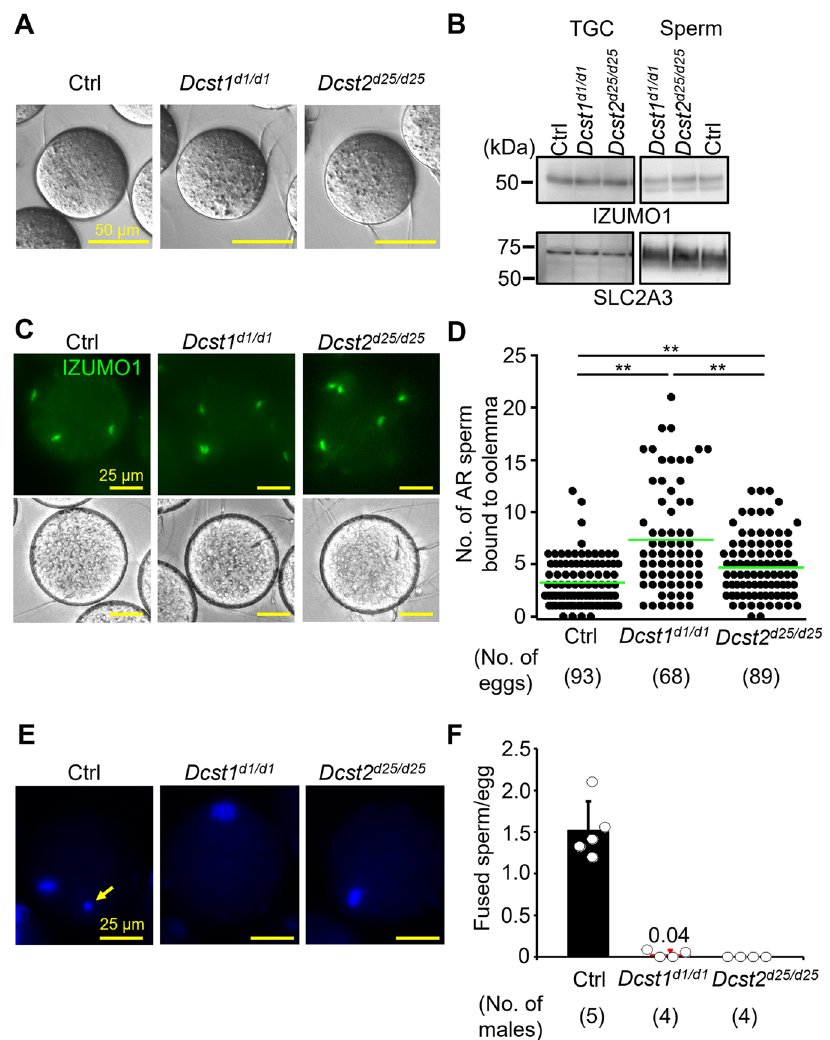
Fig. 2 Adhesion and fusion ability of Dcst1 and Dcst2 mutant sperm to oocyte plasma membrane. A Binding ability. Dcst1 KO and Dcst2 KO sperm could bind to the oolemma after 30 min of incubation. The scale bars are 50 μ m. B Detection of IZUMO1. The band signals of IZUMO1 in TGC and sperm of Dcst1 d1/d1 and Dcst2 d25/d25 male mice were comparable to the control wild-type sperm. SLC2A3, one of proteins in sperm tail, was used as the loading control. C , D Acrosome status of binding sperm. Live sperm bound to the oolemma were stained with the IZUMO1 antibody, and IZUMO1 only in the acrosome reacted (AR) sperm was detected. The AR-sperm of both Dcst mutants could bind to the oolemma, and their numbers were higher than the control heterozygous sperm [3.27 ± 2.31 (Ctrl, 93 eggs), 7.34 ± 5.09 ( Dcst1 d1/d1 , 68 eggs), 4.74 ± 2.93 ( Dcst2 d25/d25 , 89 eggs)]. ** p < 0.01. The scale bars are 25 μ m. E , F Fusion ability. The ZP-free eggs pre-stained Hoechst 33342 were used for sperm-egg fusion assay. Hoechst 33342 signal transferred to control sperm heads, indicating that sperm fused with eggs (panel E , arrow). However, Dcst1 KO and Dcst2 KO sperm rarely fused with eggs [fused sperm/ egg: 1.52 ± 0.35 (Ctrl, 113 eggs), 0.04 ± 0.05 ( Dcst1 d1/d1 , 73 eggs), 0 ( Dcst2 d25/d25 , 73 eggs)]. The scale bars are 25 μ m. All values are shown as the mean ± Dcst1 and Dcst2 disruptions are responsible for male sterility, we that control heterozygous sperm can fuse with eggs but Dcst2 KO generated transgenic mice in which a testis-speci fi c Calmegin and Dcst1 KO sperm are impaired at the step of fusion (Fig. 2E). The ( Clgn ) promoter expresses mouse DCST1 and DCST2 with an fusion defect is in agreement with the increased number of sperm HA tag at the C-terminus (Fig. S10A, B). When Dcst1 d1/d1 males with the Dcst1 -3xHA transgene and Dcst2 d25/d25 males with the bound to the oolemma due to the absence of the membrane block of Dcst2 -3xHA transgene were mated with wild-type females, the polyspermy that is normally triggered by fertilization 1 . Thus, while acrosome-reacted sperm of Dcst1 and Dcst2 KO mice can bind to females delivered normal numbers of offspring [pups/plug: eggs, they are defective at fusing with the oolemma: KO males of 5.7 ± 0.5 ( Dcst1 d1/d1 ; Tg, 25 plugs), 7.6 ± 2.7 ( Dcst2 d25/d25 ; Tg, 15 Dcst1 or Dcst2 causes a strong impairment or complete loss of plugs)] (Fig. 3A). Although both transgenes code for a C-terminal sperm-egg fusion, respectively. HA-tag and could rescue Dcst1/2 KO, only very low levels of HA- tagged DCST1 could be detected in sperm samples (Fig. S10C), suggesting that only low levels of DCST1 are required for ferti- Fecundity of Dcst1 d1/d1 and Dcst2 d25/d25 males is rescued by lization. HA-tagged DCST2 was detected in TGCs and sperm at Dcst1 -3xHA and Dcst2 -3xHA transgenes . To con fi rm that the the expected size for the full-length protein (Figs. 3B and S10C,